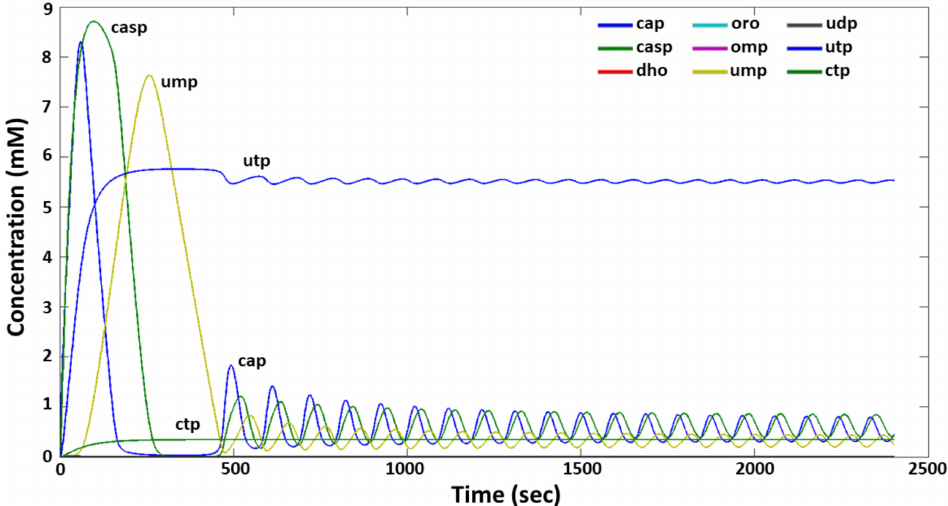
Figure 3. The oscillatory mode of functioning with manual method of the model analysis at h UMP1 = 2.1, k 2 = 0.0031, k 3 = 0.00351, k 9 = 0.000174 and r = 1. Values of other parameters are given in Table S4 (column “manual”, Supplementary Text S3). The X axis is time (sec), the Y axis is the concentration of metabolites (mM). The designations of metabolites and colors of their concentration curves are similar to those in Figure